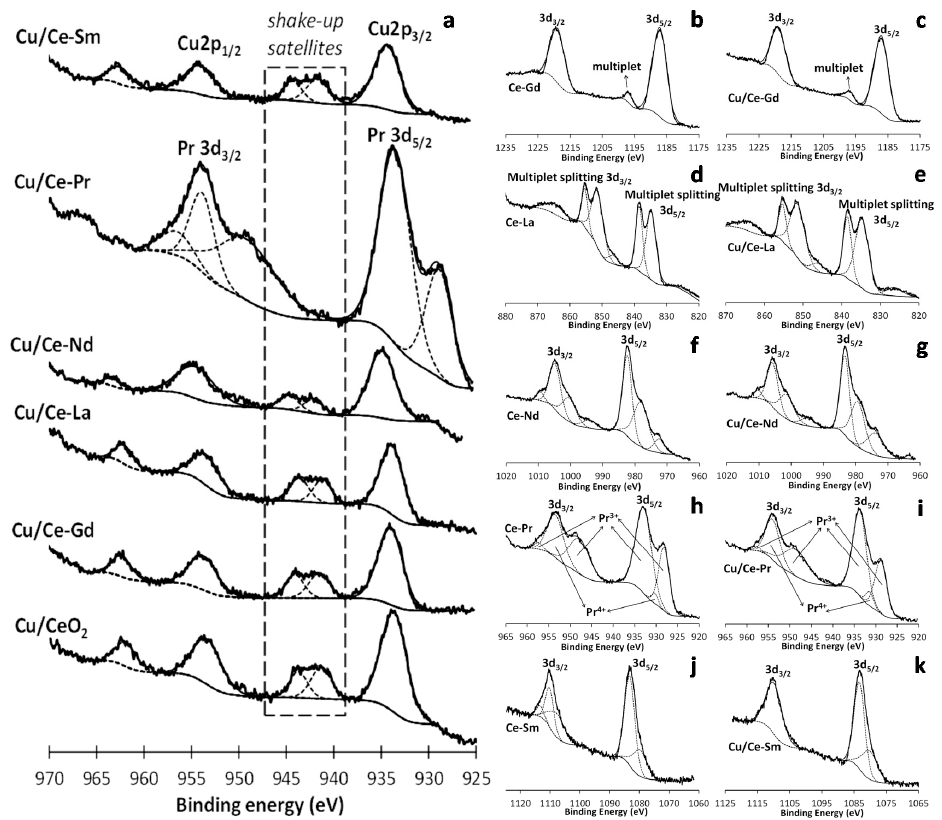
Figure 6. XPS Cu 2p spectra of the Cu/Ce-Ln samples, where Ln: Gd, La, Pr, Nd, Sm ( a ); Gd 3d XPS spectra of Ce-Gd ( b ) and Cu/Ce-Gd ( c ); La 3d XPS spectra of Ce-La ( d ) and Cu/Ce-La ( e ); Nd 3d XPS spectra of Ce-Nd ( f ) and Cu/Ce-Nd ( g ); Pr 3d XPS spectra of Ce-Pr ( h ) and Cu/Ce-Pr ( i ); and Sm 3d XPS spectra of Ce-Sm ( j ) and Cu/Ce-Sm ( k ).